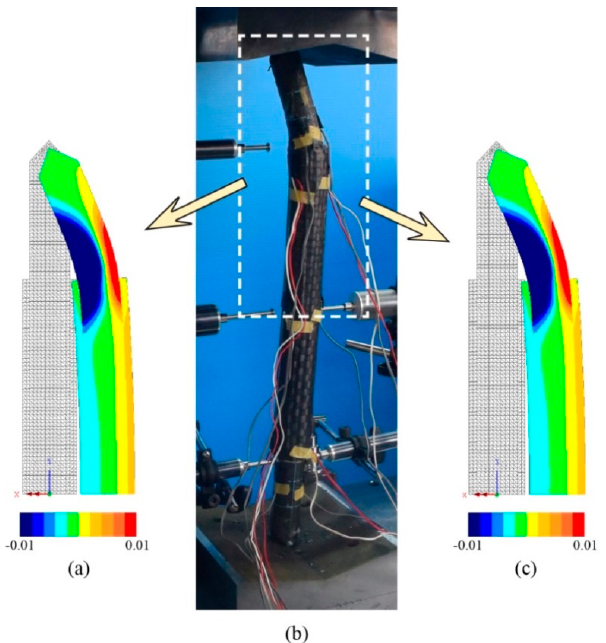
Figure 10. Failure mode of specimen with 340 mm strengthening length: ( a ) BL56F34-1-FE along with longitudinal ( z ) strain contour, ( b ) typical experimental failure for BL56F34-1 and BL56F34-2, and ( c ) BL56F34-2-FE along with longitudinal ( z ) strain contour.